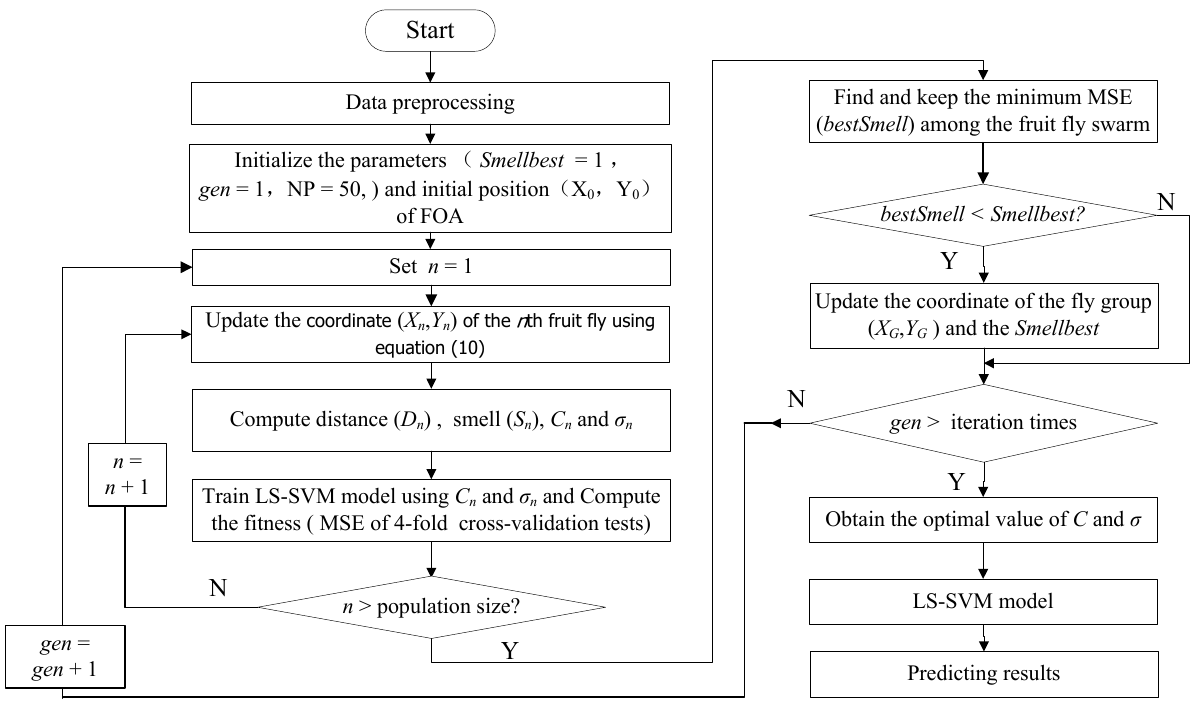
Figure 2. The flow diagram of fruit fly optimization algorithm